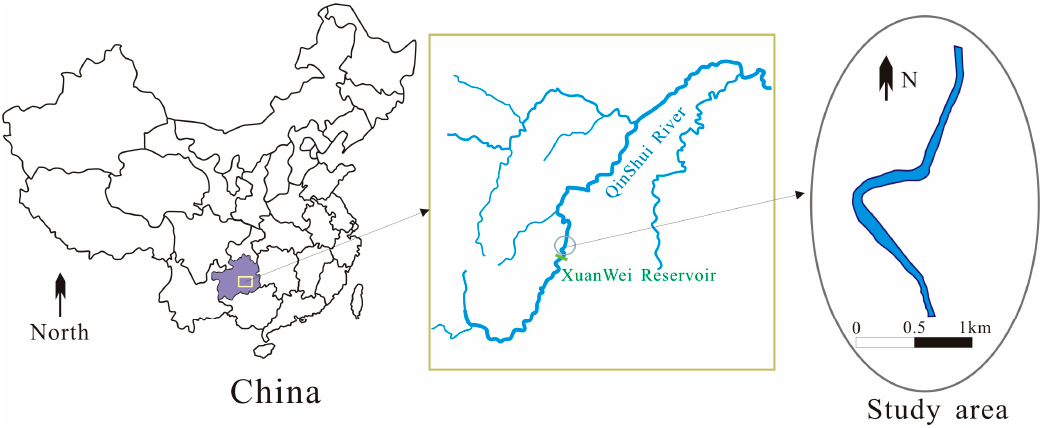
Figure 1. Study area.